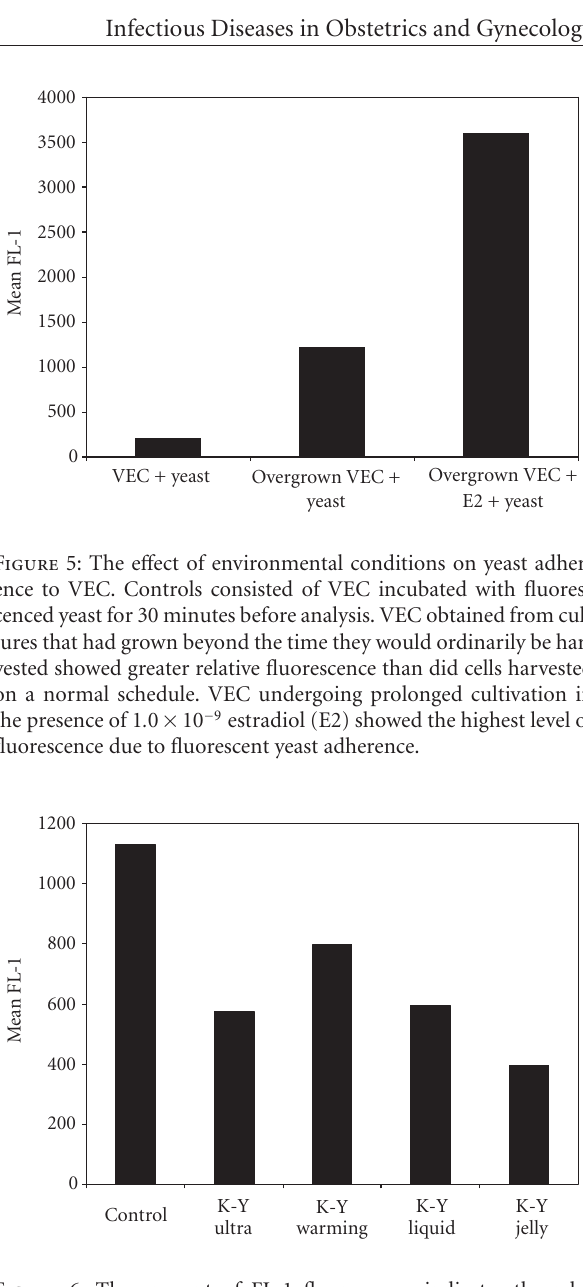
Figure 6: The amount of FL-1 fluorescence indicates the rela- tive density of yeast binding to VEC. Controls represent fluoresci- nated yeast bound to VEC. The remaining bars indicate the bind- ing of yeast to VEC previously treated with each of 4 K-Y products. The lower fluorescence after K-Y treatment indicates reduced yeast binding to